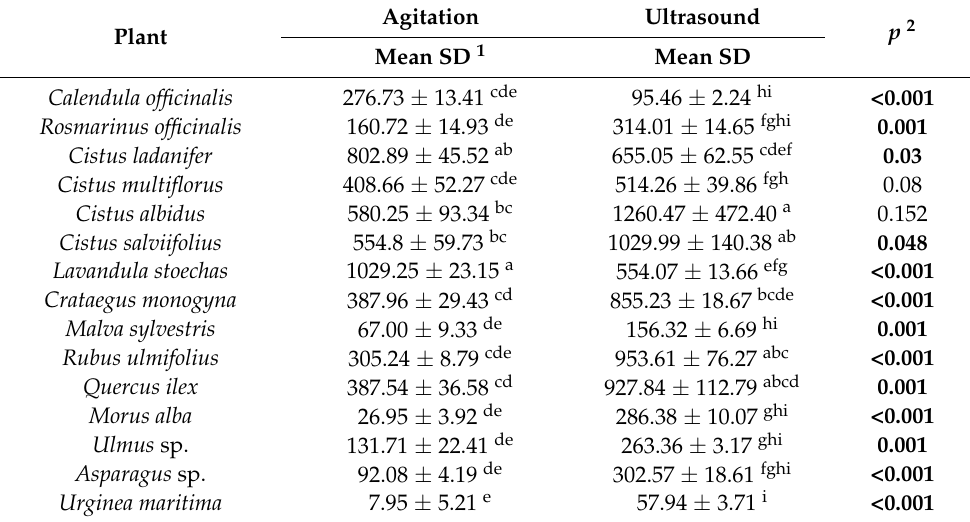
Table 1. Total phenolic compounds of plants expressed in mg of gallic acid equivalents (GAE)/100 g fresh